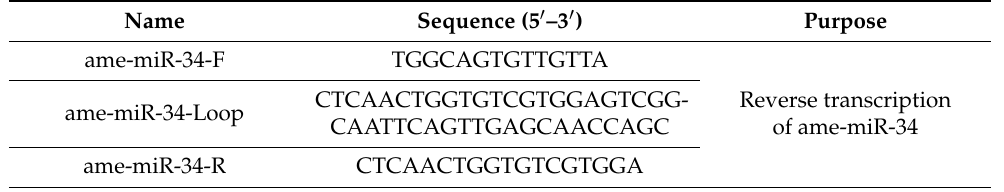
Table 1. Detailed information about primers for